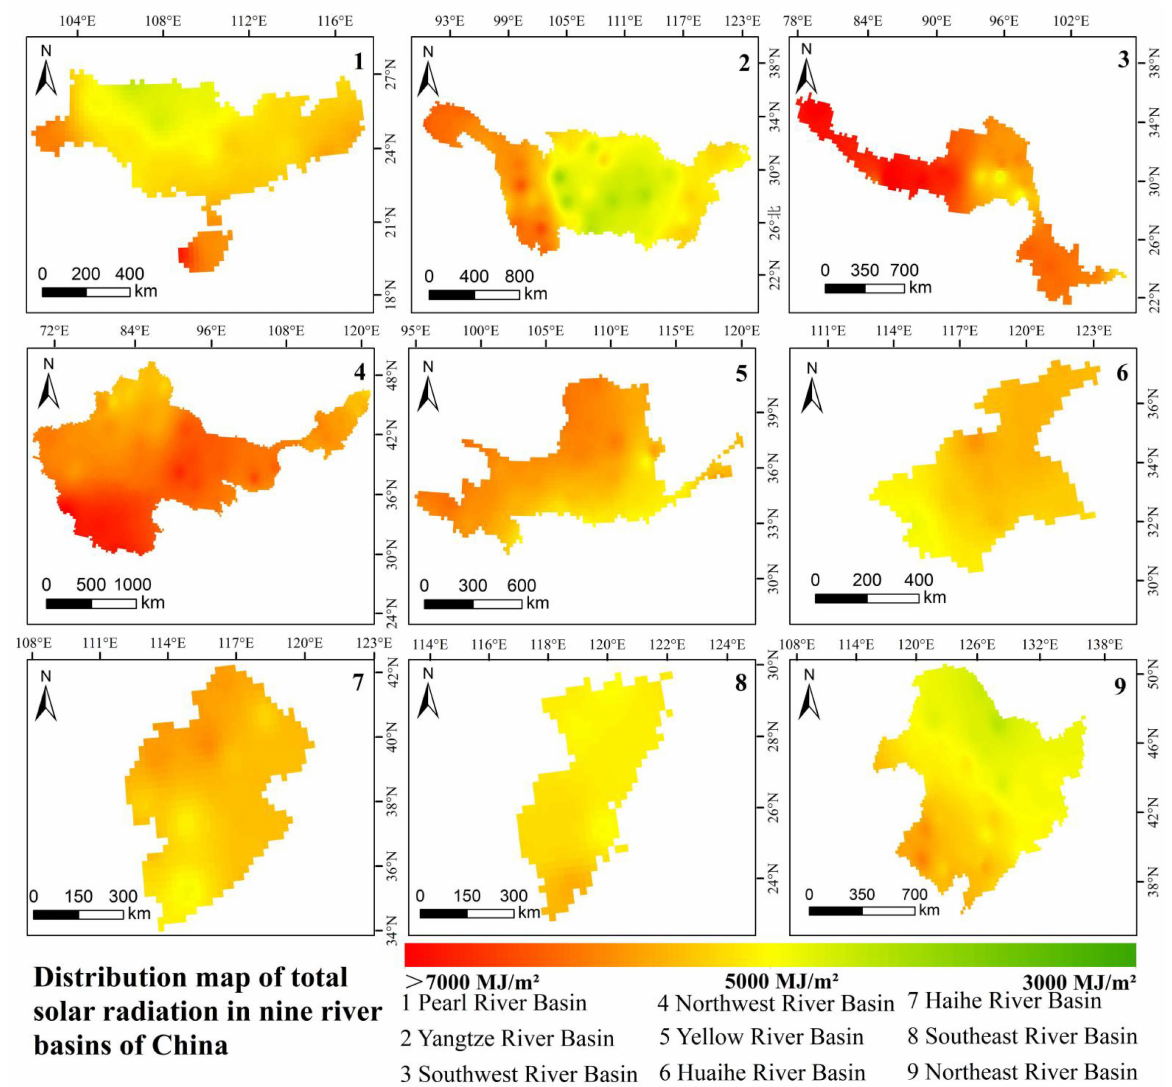
Figure 6. Spatial distribution of annual mean solar radiation over Chinese river